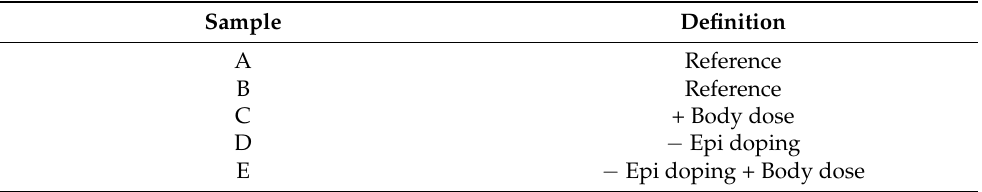
Table 1. Sample description: two reference samples A and B are compared with a p-type implanted dose variation in C, epitaxial layer doping variation in D, and their combination in